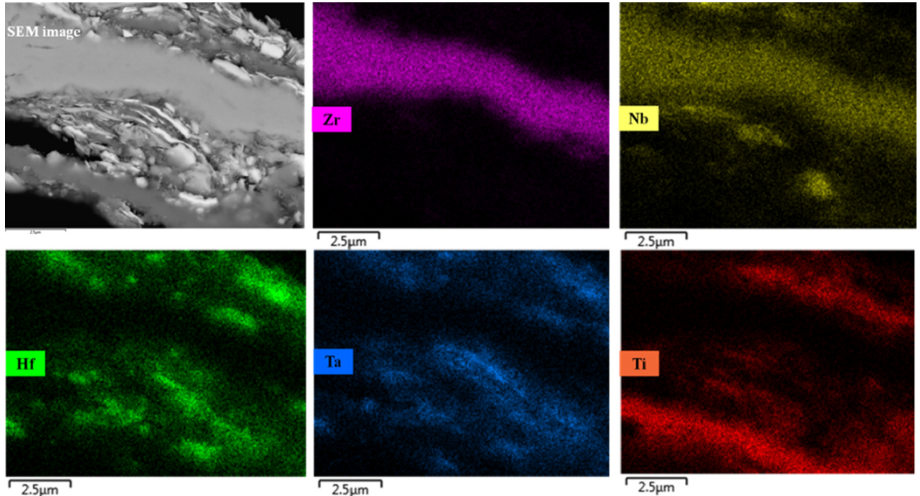
Figure 6. Representative compositional EDS mapping results for the HfTaTiNbZr sample ball milled for 5 h.